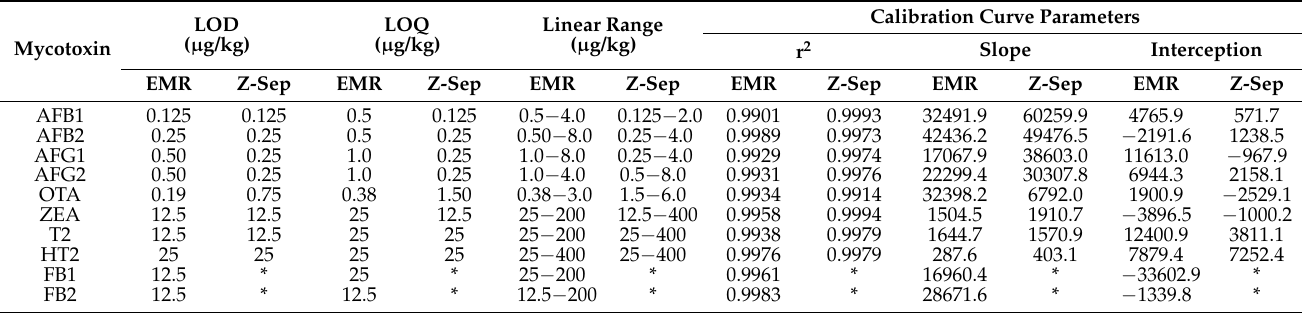
Table 1. Linearity and sensitivity of UHPLC-ToF-MS method for the simultaneous determination of mycotoxins in pistachio.